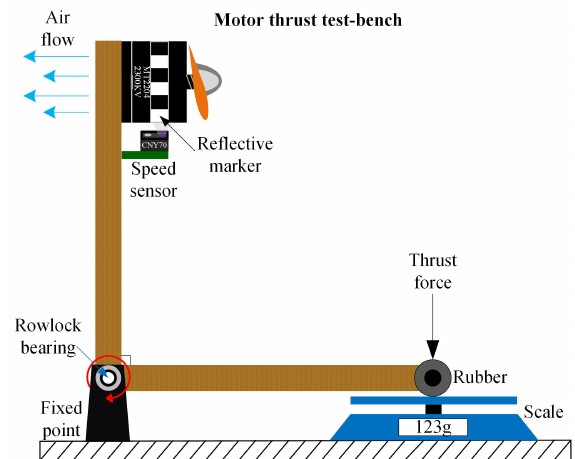
Figure 5. Thrust force test-bench for obtaining the thrust coefficient.